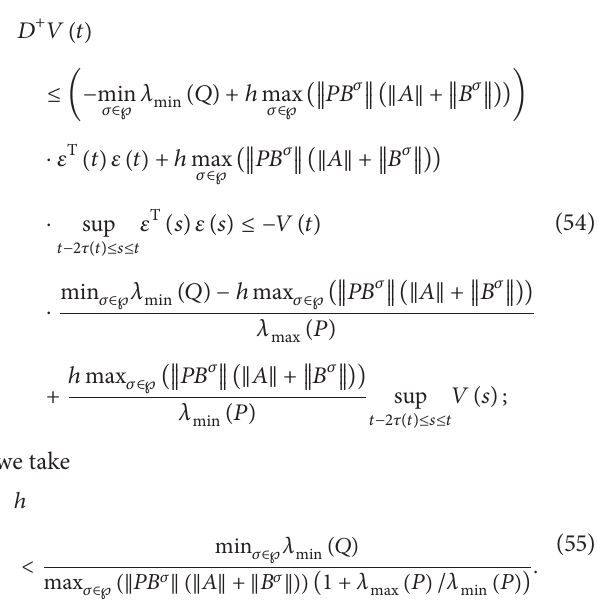
network. Considering twelve second-order nodes in the dynamical network with switching topologies {𝐺 𝑎 , 𝐺 𝑏 , 𝐺 𝑐 } , Figure 1 gives three strongly connected and balanced graphs with 0–2 weights. The initial values of 𝑥 𝑖 and V 𝑖 are selected randomly in the regions [0, 800] × [0, 800] and [0, 800] × [0, 800] , respectively. nodes are = diag {1, 1, 1, 1}, 𝑀 = diag {2, 2, 2, 2}, . . . , 𝑀 = 𝑀 1 2 12 diag {12, 12, 12, 12} . It is known from Theorem 5 that there exists a proper ℎ > 0 for any switching signal 𝜎(𝑡) such that (22) is exponential stable for zero solution. Let 𝑏 = 1 , 𝑘 = 0.6 , 𝛼 = 0.3 , and 𝑟 = 0.2 . Through the use of Theorem 5, the maximum upper bound of time delay ℎ = 0.12 can be acquired; the corresponding solutions are as